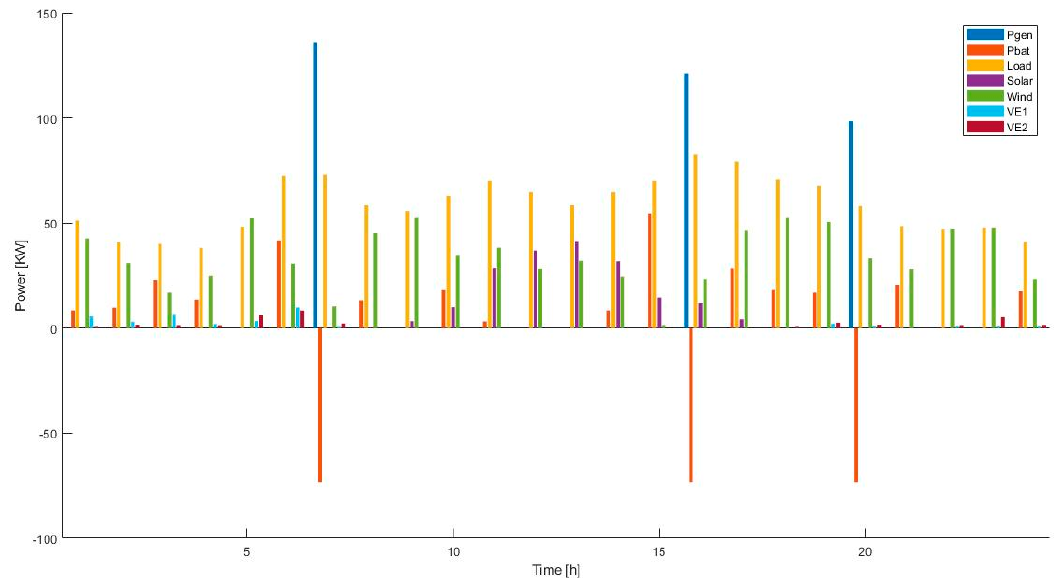
Figure 14. Availability and dispatch of the MG with the storage system after the 30% of its useful life.